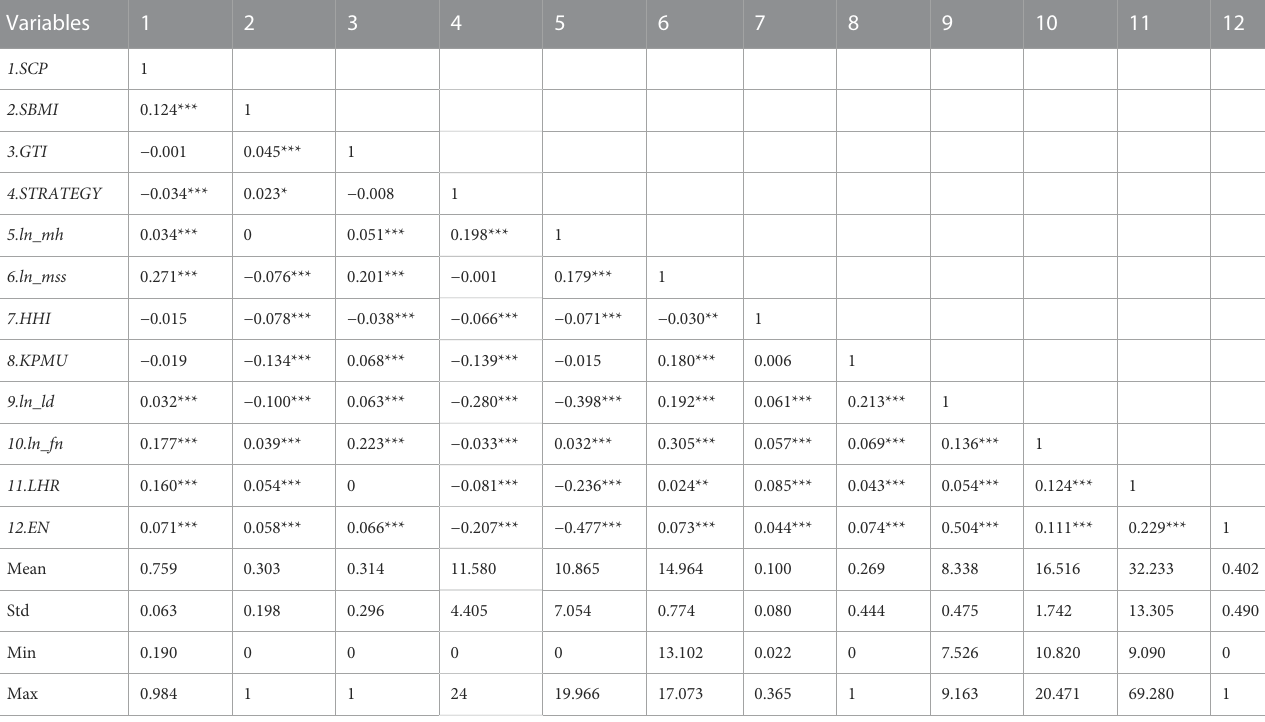
TABLE 2 Descriptive statistics and correlations of the main variables.